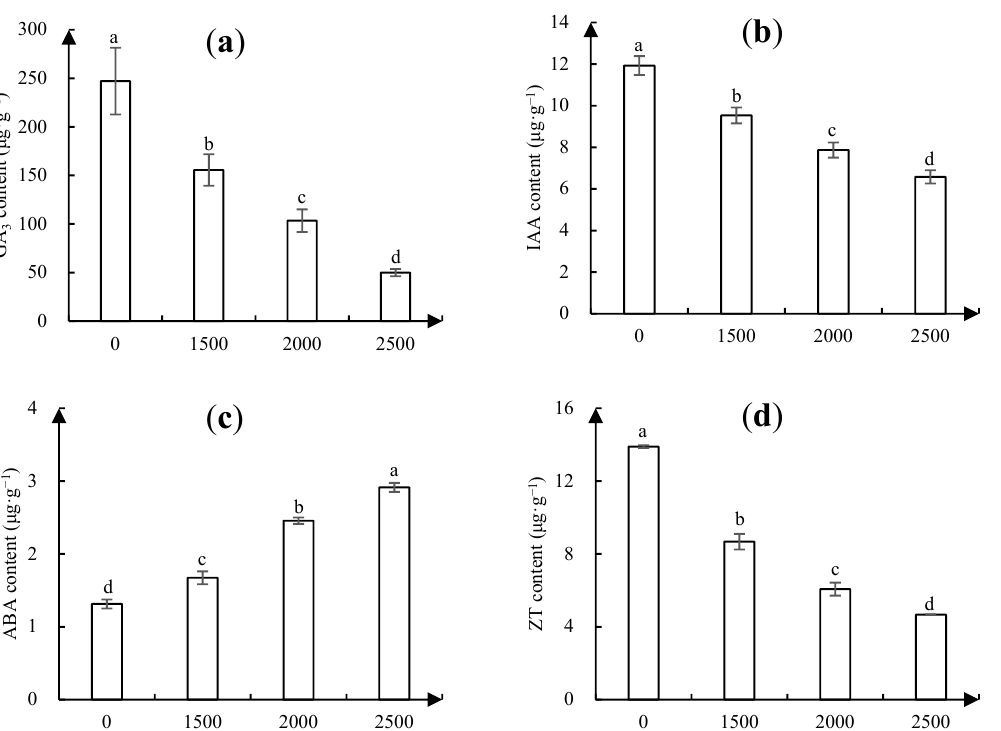
Figure 6. The effects of different concentrations of uniconazole on GA 3 ( a ), IAA ( b ), ABA ( c ) and ZT ( d ) content in M. wufengensis .